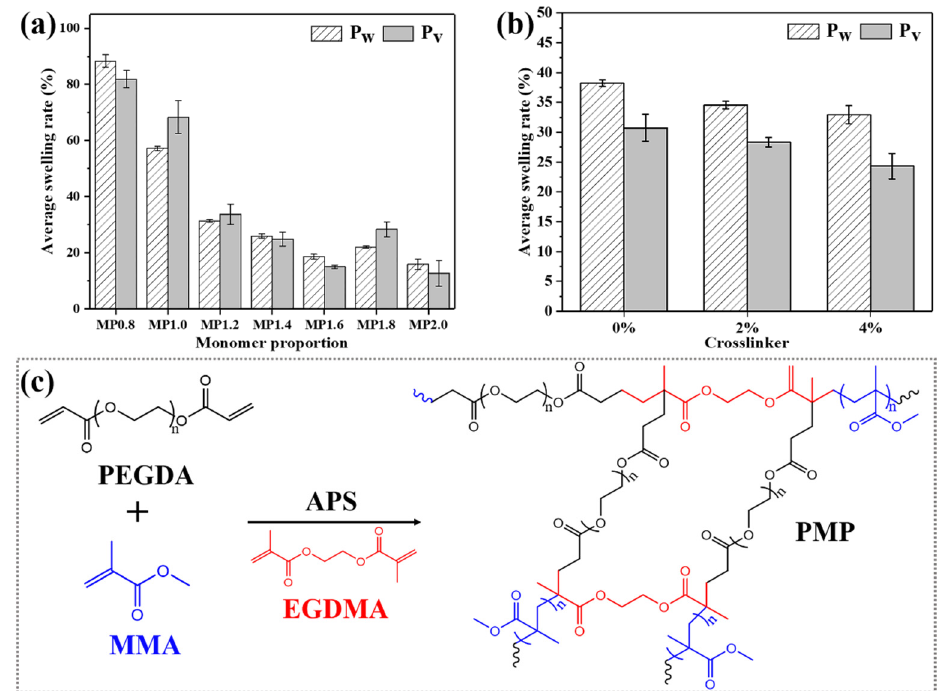
Figure 1. The effect of monomer proportion ( a ) and crosslinker ( b ) on the average swelling rate of PMP. ( c ) Schematic presentation of the MMA/PEGDA cross-linked copolymer network.